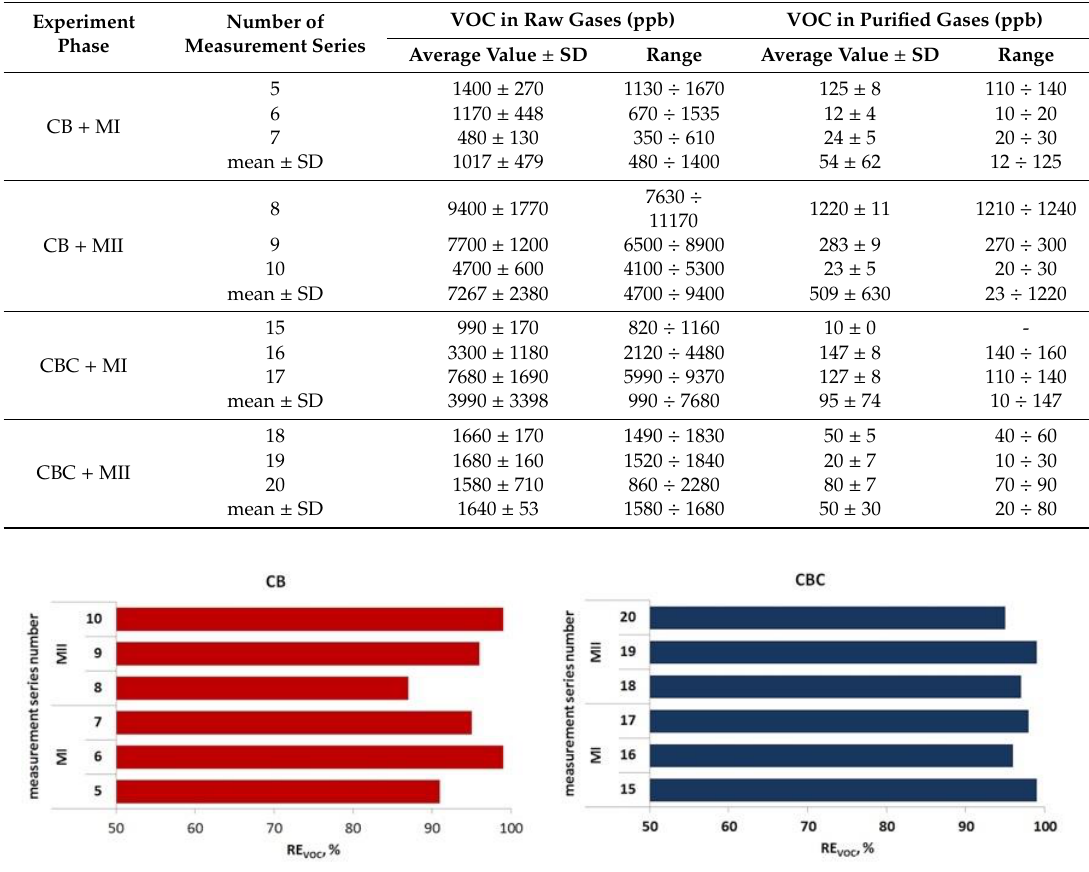
Table 6. VOC concentrations in raw and purified gases during subsequent phases of two-stage biofiltration–for each measurement series.